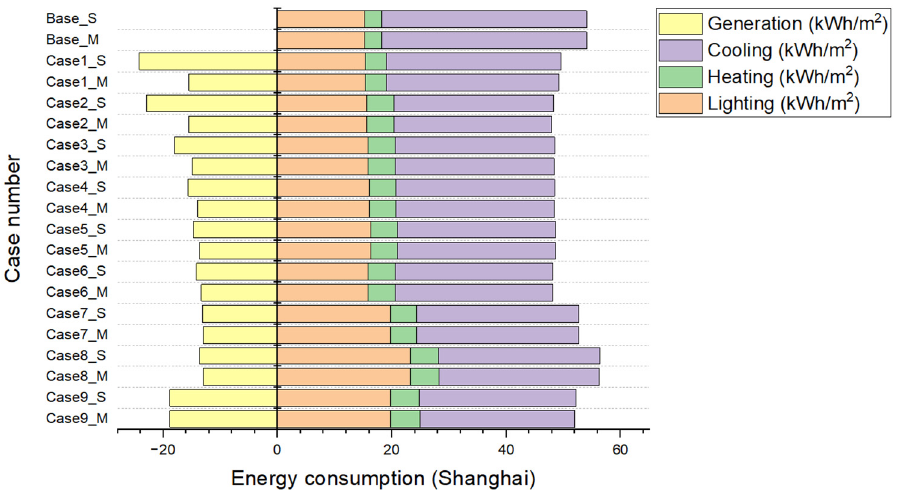
Figure 10. Energy consumption of single-story and multi-story buildings (in Shanghai) with differ- ent